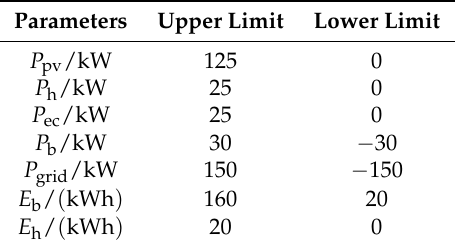
Table 2. Parameters of microgrid operation.